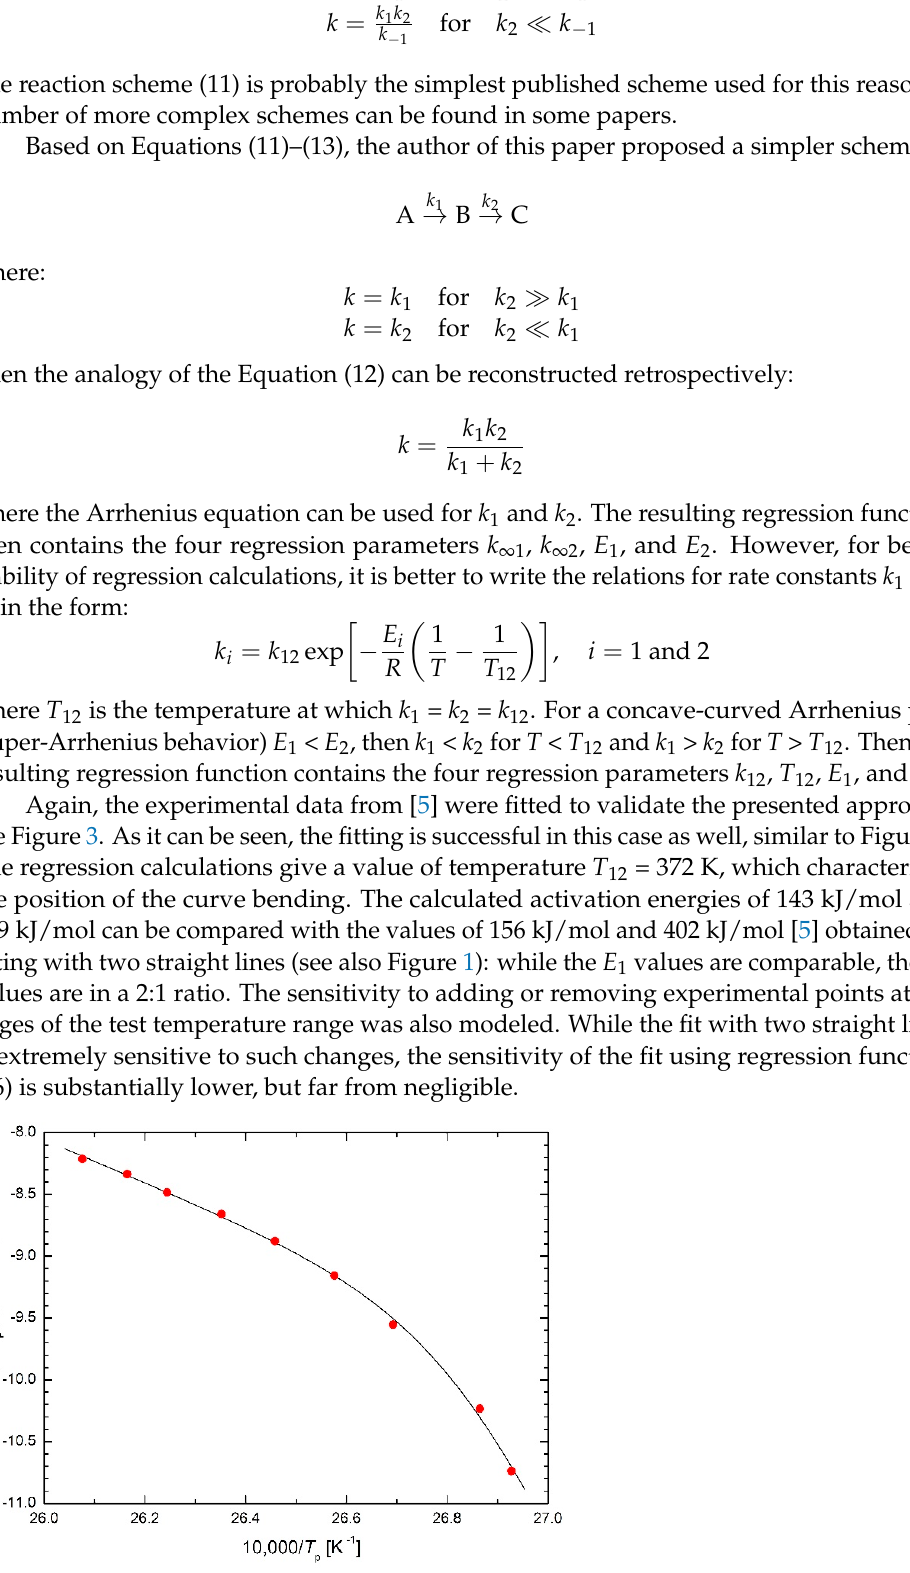
Figure 3. Kissinger plot for Ni-Mn-In-Mg shape memory alloy [5] using Equations (16) and (17) as regression functions.